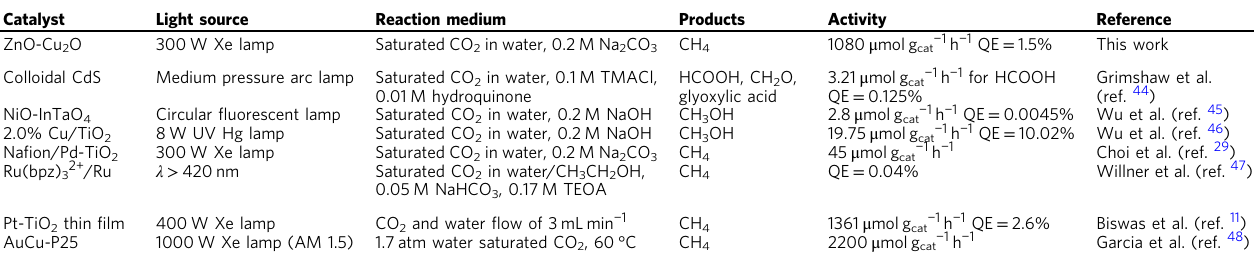
Table 1 Comparison of the reaction conditions and performances with other catalysts for photocatalytic CO 2